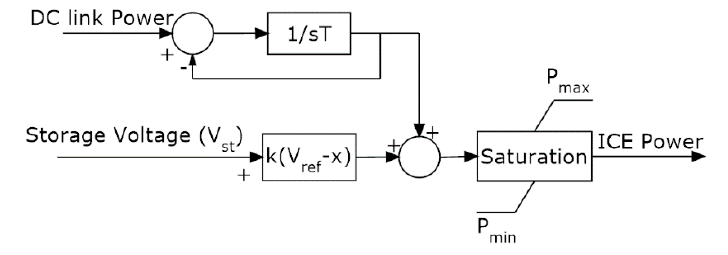
Figure 3. Engine Power Management System (EPMS).